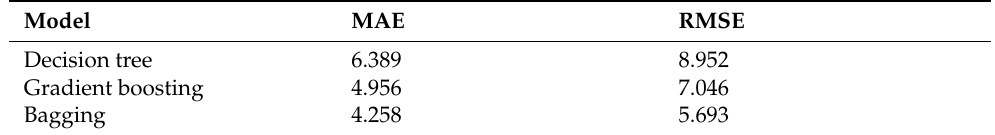
Table 2. Statistical assessments of the models.